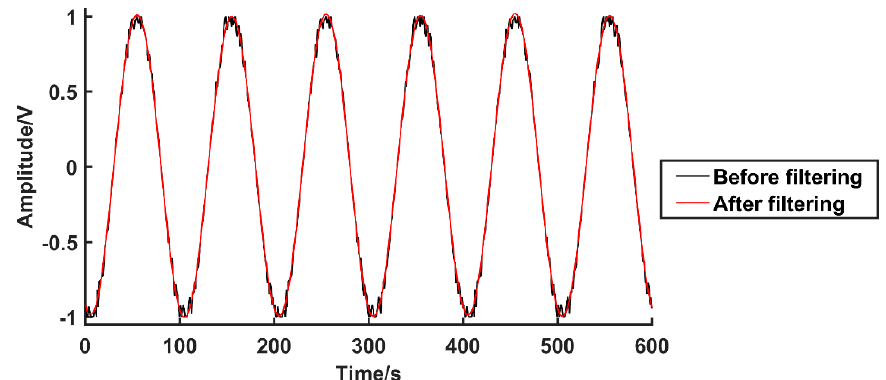
Figure 11. Sinusoidal signals before and after zero phase bandpass filter.